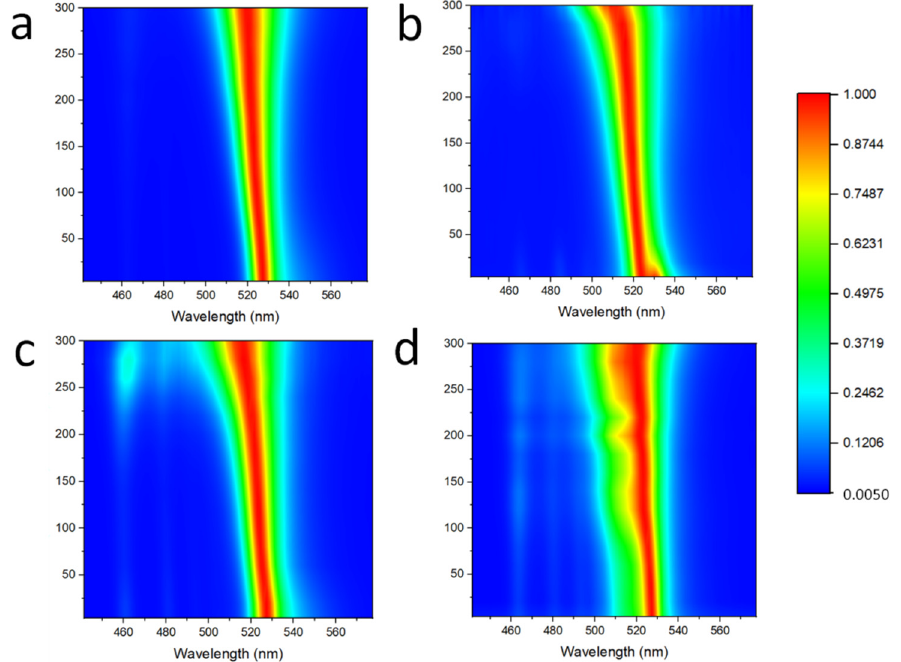
Figure 5. Temperature-dependent PL spectra of mixed-cation perovskite QDs: ( a ) Cs = 0; ( b ) Cs = 0.1; ( c ) Cs = 0.15; and ( d ) Cs = 0.2.